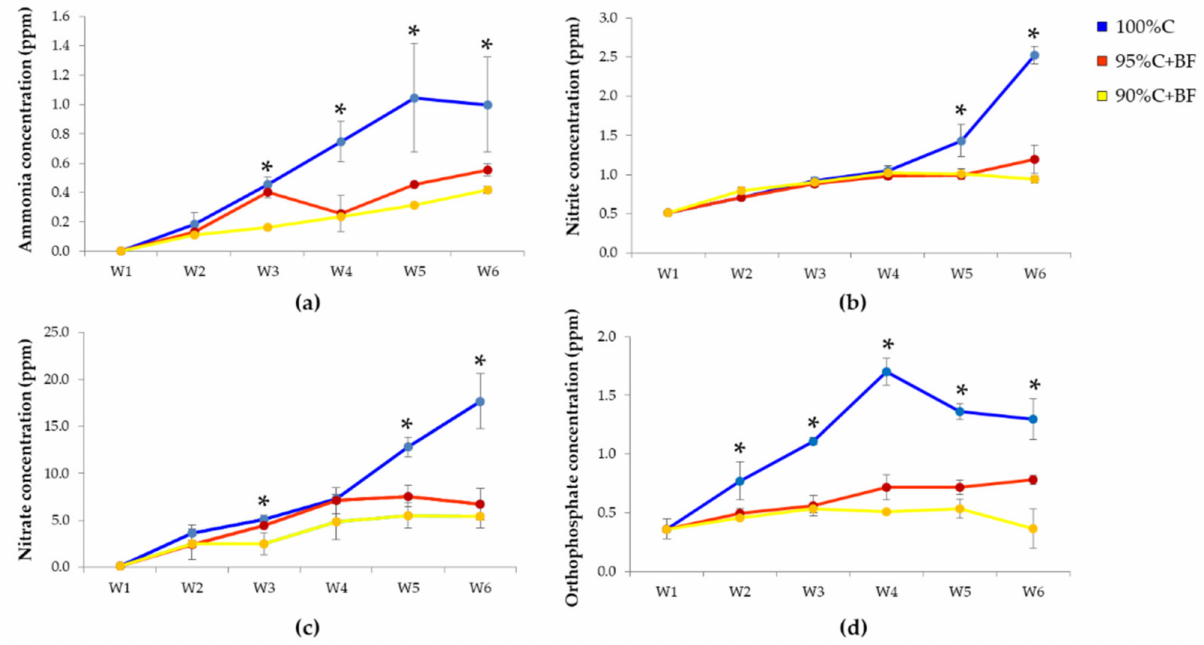
Figure 2. Concentrations of ammonia ( a ), nitrite ( b ), nitrate ( c ) and orthophosphate ( d ) concentrations during 6 weeks (W1-W6) of experiment using commercial pellet treatment without biofloc supplementation (100%C; blue), 5% ( w / w ) feed reduction supplemented with 0.3% ( v / v ) biofloc (95%C+BF; red) and 10% ( w / w ) feed reduction supplemented with 0.3% ( v / v ) biofloc (90%C+BF; yellow). Error bars represent a value of ± standard derivation. An asterisk represents a significant difference among the three groups at particular time point ( p < 0.05).